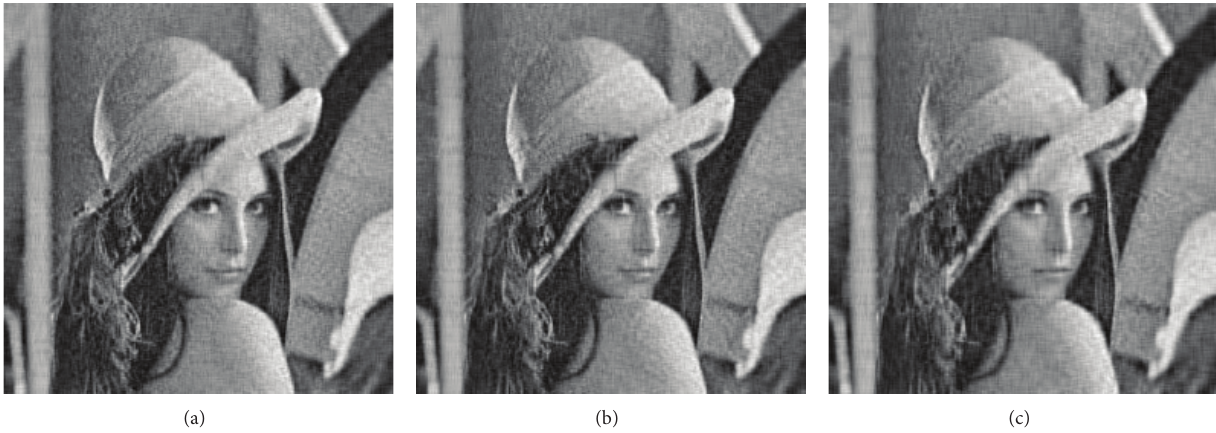
Figure 2: Image compression by Algorithm 6 with different rank 𝑑 : (a) 𝑑 = 40 ; (b) 𝑑 = 30 ; and (c) 𝑑 = 20 .